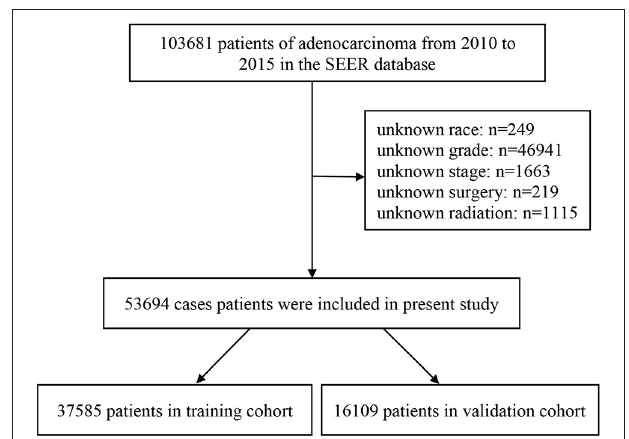
FIGURE 1 | A flow diagram of patient selection